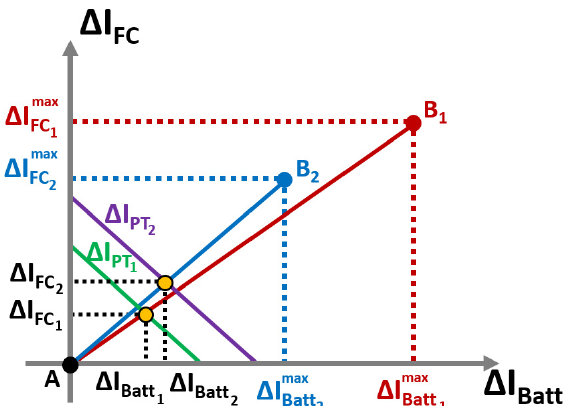
Figure 8. Intersection between the linear relationship for power splitting and the load curve for different ∆ I PT values.